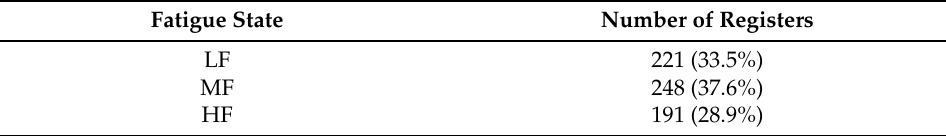
Table 3. The number of registers for each fatigue